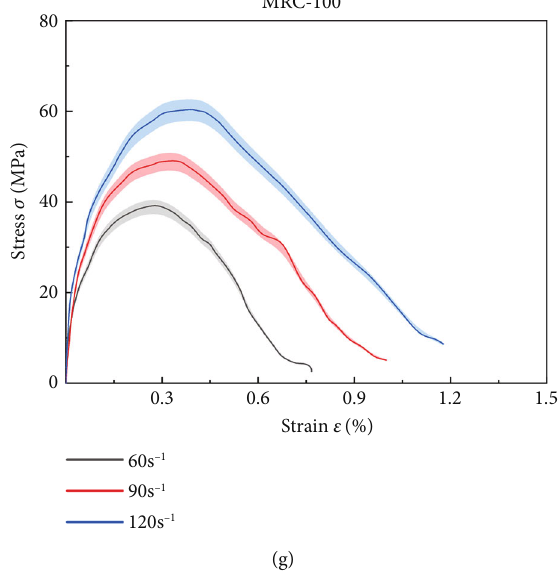
Figure 4: Dynamic stress – strain curves of RC and MRC: (a) C; (b) RC-30; (c) RC-60; (d) RC-100; (e) MRC-30; (f) MRC-60; (g) MRC-100.